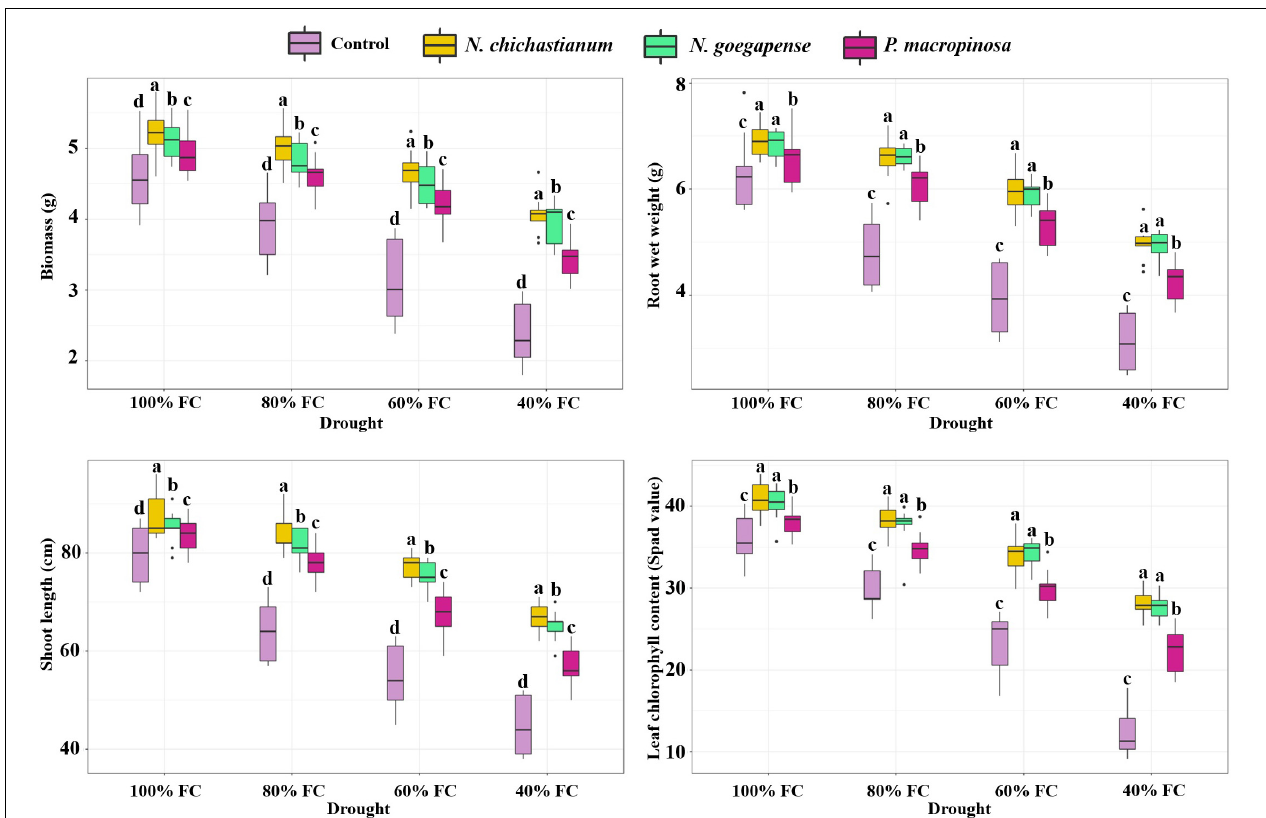
FIGURE 1 | The positive effects of halotolerant endophytic fungi species on drought stress resistance abilities of barley plants. Different levels of drought stress and different fungal treatment are shown on the horizontal axis and colorful boxes, respectively. Various letters on the top of bars display significant differences between mean values of different fungal treatments under the different levels of drought stress at p ≤